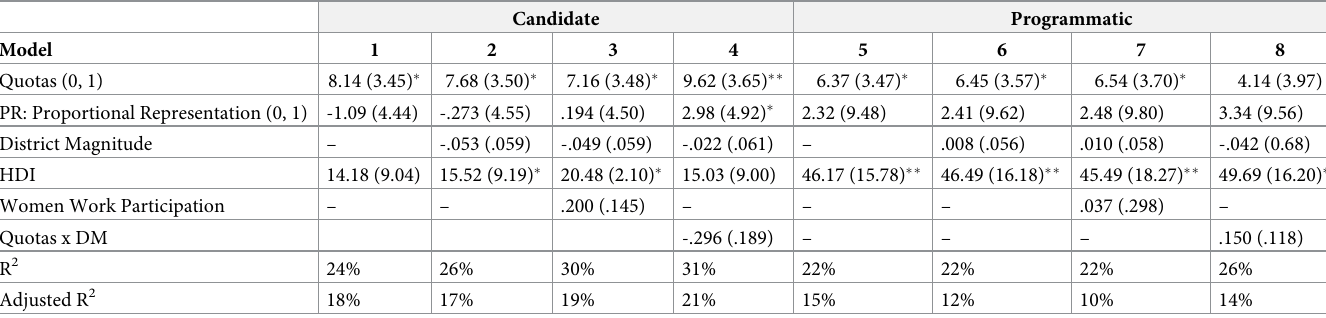
Table 2. Women’s representation in parliaments, by system